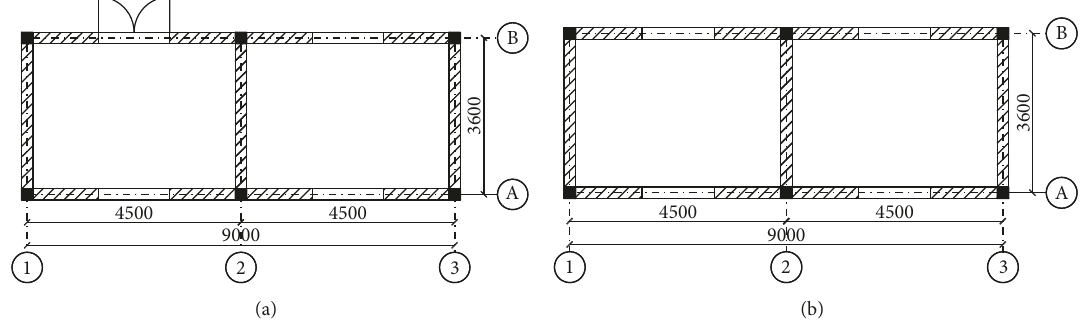
Figure 1: Layouts of the model: (a) first floor and (b) second floor.